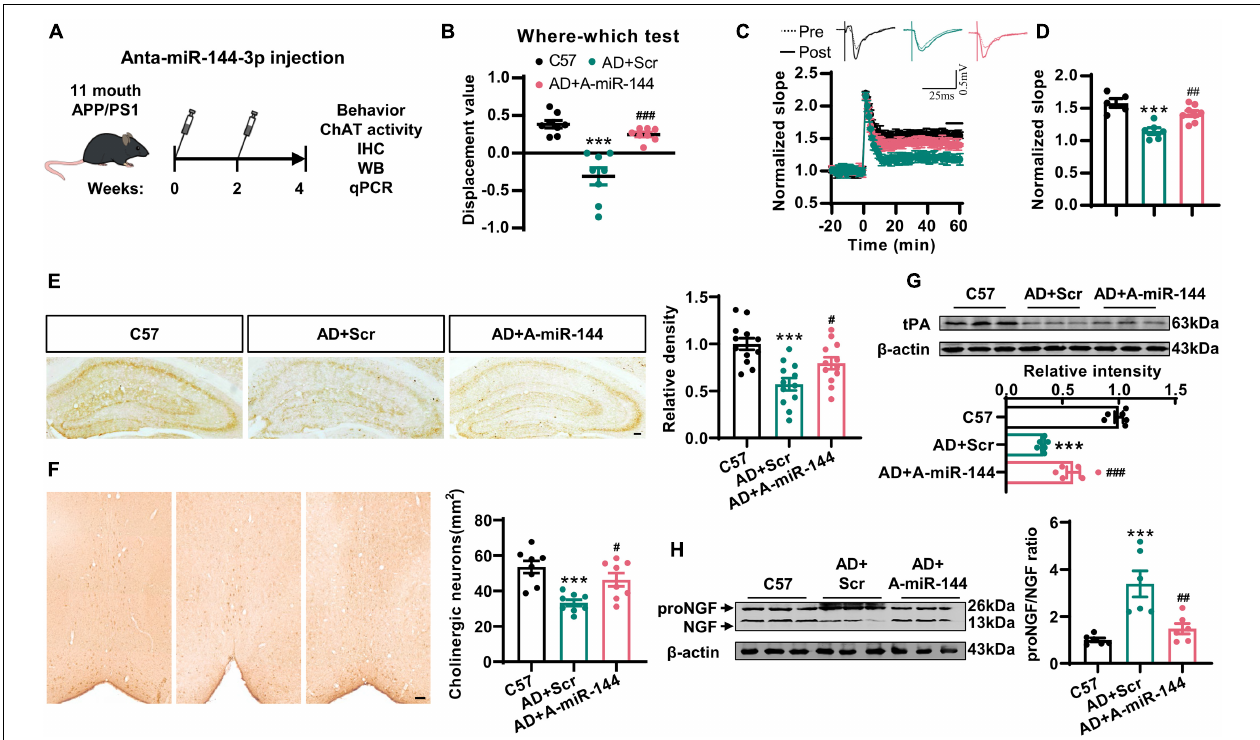
FIGURE 6 | The inhibition of miR-144-3p rescued cholinergic degeneration and synaptic/memory impairments in APP/PS1 mice. (A) The flow diagram of administration of miR-144-3p antagomir. The miR-144-3p antagomir was injected into the hippocampal CA3 of 11-months-old APP/PS1 mice that were used for subsequent experiments. (B) The where–which test was used to assess the context memory in C57, APP/PS1 + Scr (AD + Scr) and APP/PS1 + A-miR-144 (AD + A-miR-144) groups. Ordinary one-way ANOVA with Tukey’s multiple comparisons, n = 8 mice for each group, *** p < 0.001 for AD + Scr vs. C57 and ### p < 0.001 for AD + A-miR-144 vs. AD + Scr. (C) The electrophysiological recording to detect the fEPSP slope was used to evaluate the CA3–CA1 LTP of those three groups. The representative fEPSP traces were shown in the upper panel, and the relative fEPSP slopes were shown in the lower panel. n = 5–8 slices from three mice for each group. (D) The fEPSP slope of the last 5 min was statistically analyzed. n = 5–8 from three mice for each group, *** p < 0.001 for AD + Scr vs. C57 and ## p < 0.01 for AD + A-miR-144 vs. AD + Scr. (E) Representative immunohistochemical images in the hippocampi from mice in those three groups were shown in the left panel, and the quantitative analysis was shown in the right panel. Bar = 100 µ m. Ordinary one-way ANOVA with Tukey’s multiple comparisons, n = 12 from four mice for each group, *** p < 0.001 for AD + Scr vs. C57 and # p < 0.05 for AD + A-miR-144 vs. AD + Scr. (F) Representative immunohistochemical images of ChAT-positive neurons in the basal nucleus of Meynert were shown. Bar = 100 µ m. The quantitative analysis was indicated in the right panel. Ordinary one-way ANOVA with Tukey’s multiple comparisons, n = 8 from four mice for each group, *** p < 0.001 for AD + Scr vs. C57 and # p < 0.05 for AD + A-miR-144 vs. AD + Scr. (G) The protein level of tPA was detected in those mice by western blotting, and the quantitative analysis was shown. Ordinary one-way ANOVA with Tukey’s multiple comparisons, n = 6 mice for each group, *** p < 0.001 for AD + Scr vs. C57 and ### p < 0.001 for AD + A-miR-144 vs. AD + Scr. (H) The protein level of tPA was detected in the left panel, and the quantitative analysis was shown in the right panel. Ordinary one-way ANOVA with Tukey’s multiple comparisons, n = 6 mice for each group, *** p < 0.001 for AD + Scr vs. C57 and ## p < 0.01 for AD + A-miR-144 vs. AD +